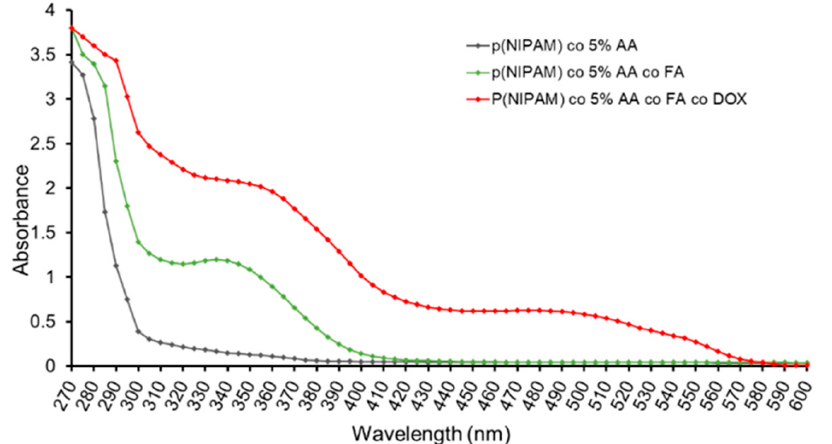
Figure 1. UV-VIS spectra of p(NIPAM)-co-5%AA, p(NIPAM)-co-5%AA-co-FA, and p(NIPAM)-co- 5% AA-co-FA-co-Dox.